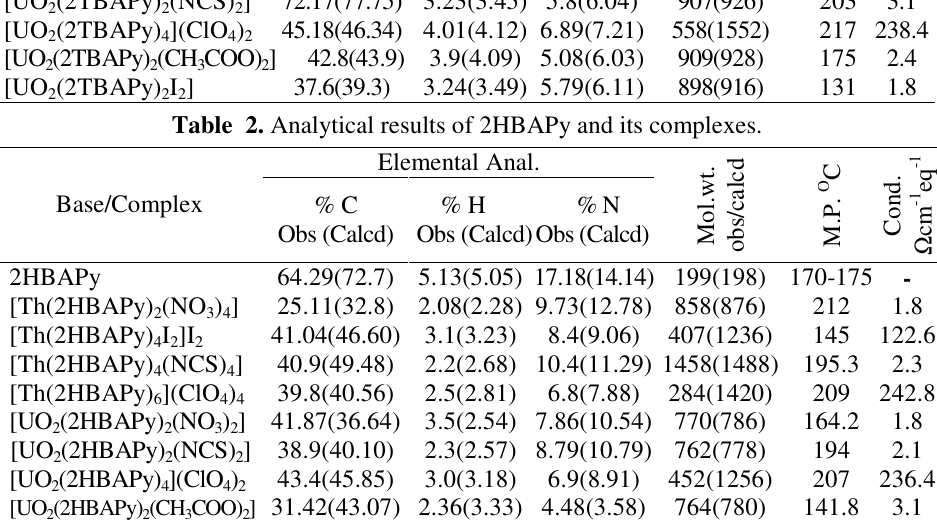
Table 2. Analytical results of 2HBAPy and its complexes. Elemental